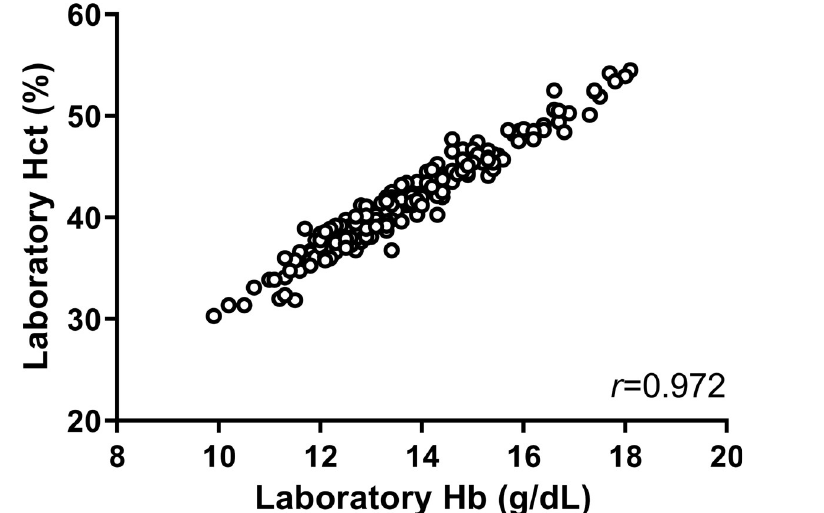
Fig 1. Scatter plot of laboratory hemoglobin and